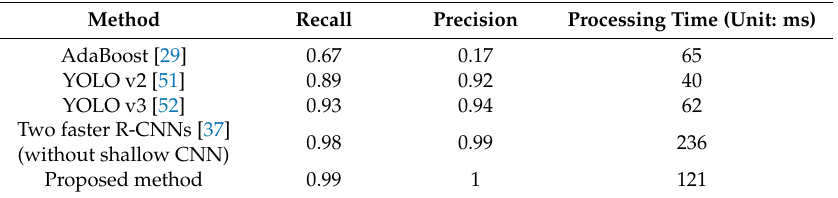
Table 9. Comparisons of recall, precision, and processing time of the proposed and previous methods at an IOU threshold of 0.5.